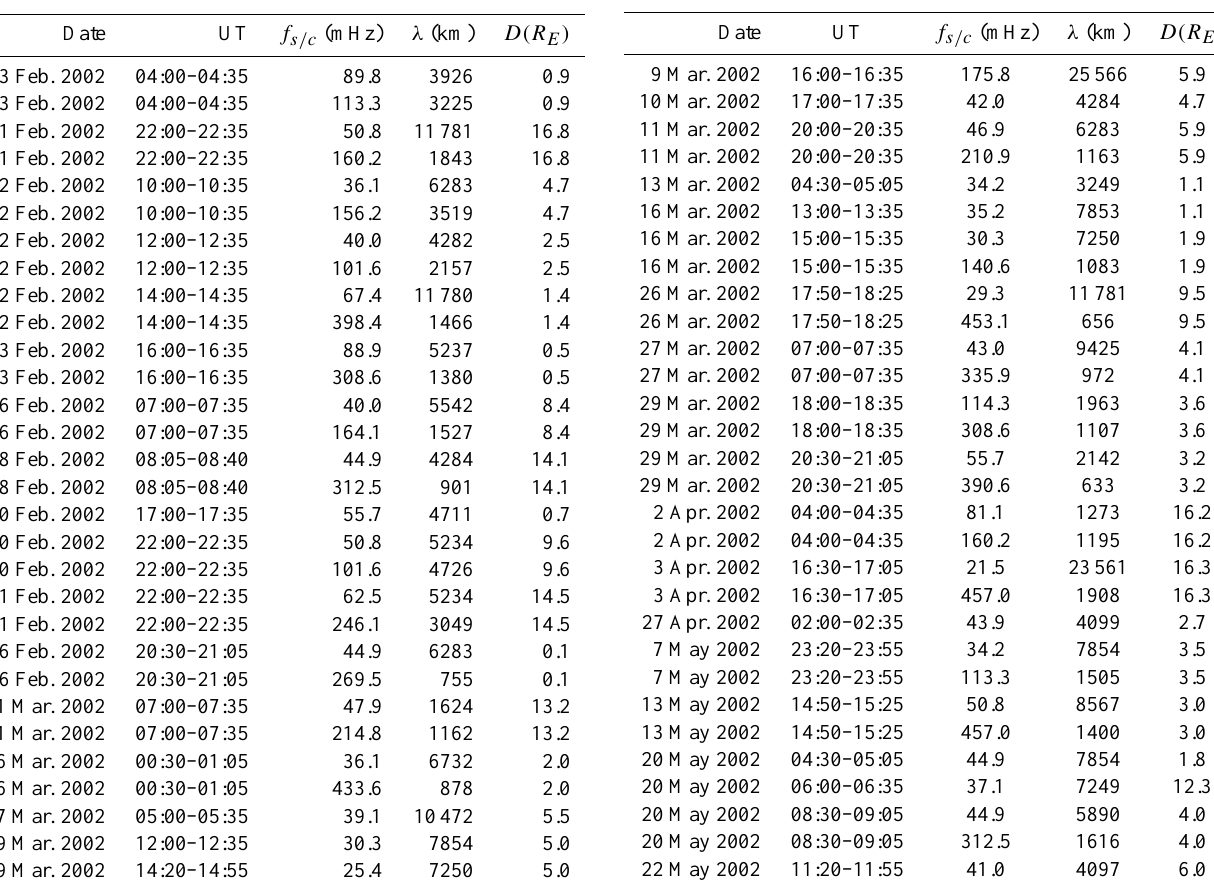
Table 1. Intervals, spacecraft frame frequencies, wavelengths, and the distances from the shock to Cluster 3 along IMF line of the foreshock wave